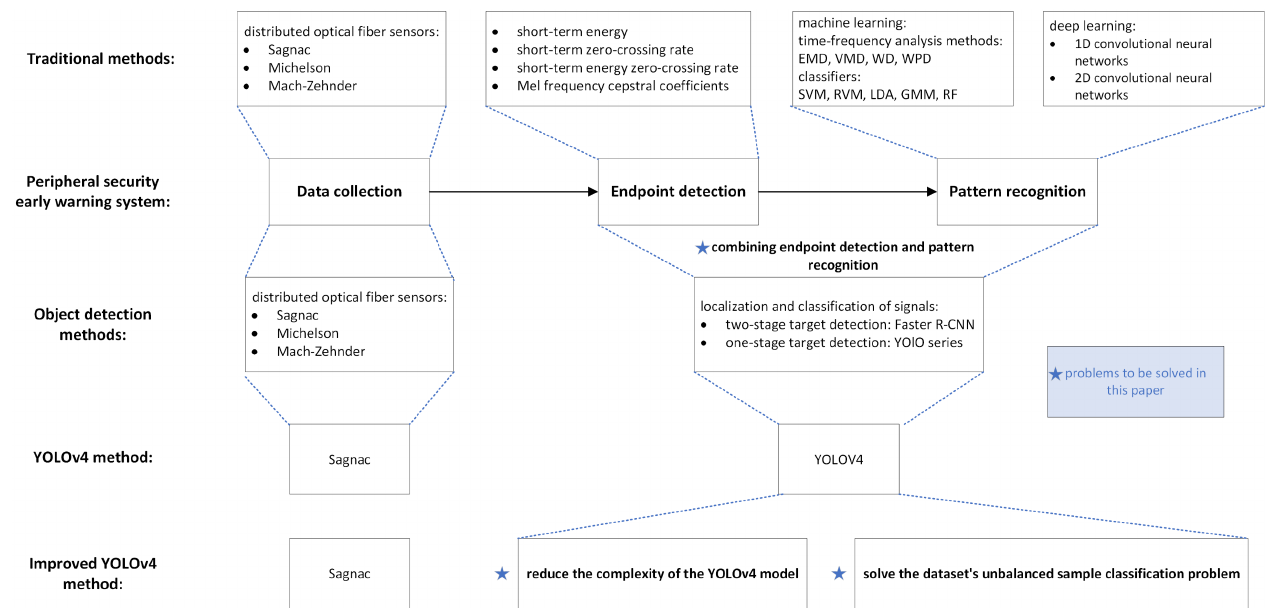
Figure 1. The problem solved in this paper and the method proposed.